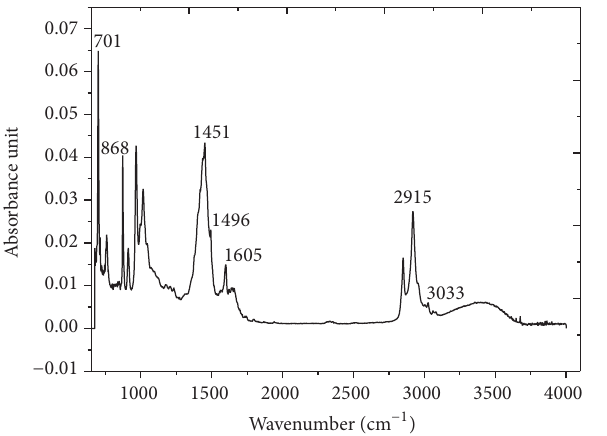
Figure 2: Baseline-corrected infrared spectrum of latex foam.